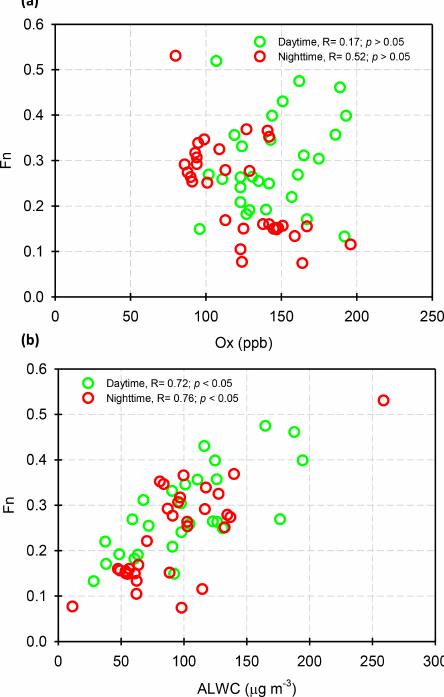
Figure 7. Scatter plots of (a) F n against O x and (b) F n against ALWC in daytime and nighttime aerosol samples during the high hourly PM 2 . 5 concentration conditions (hourly PM 2 . 5 ≥ 150µgm − 3